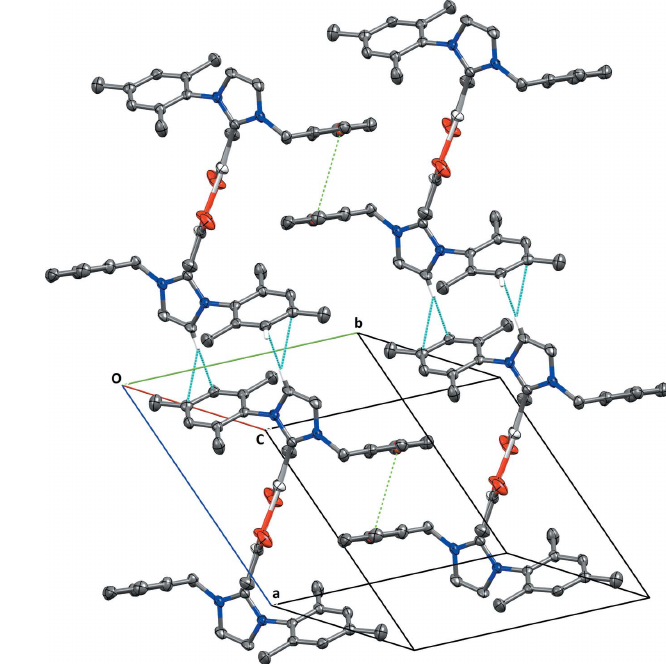
Figure 2 Intermolecular C—H (cid:4)(cid:4)(cid:4) . (cid:2) interactions and (cid:2) – (cid:2) stacking interactions (shown as dotted lines) for compound 2